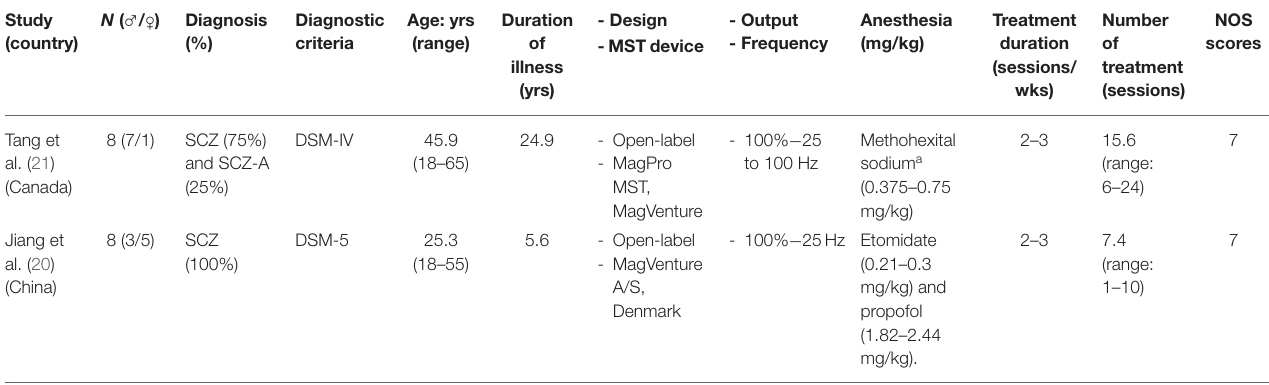
TABLE 1 | Summary of characteristics of included studies. N ( ♂ / ♀ Study (country)